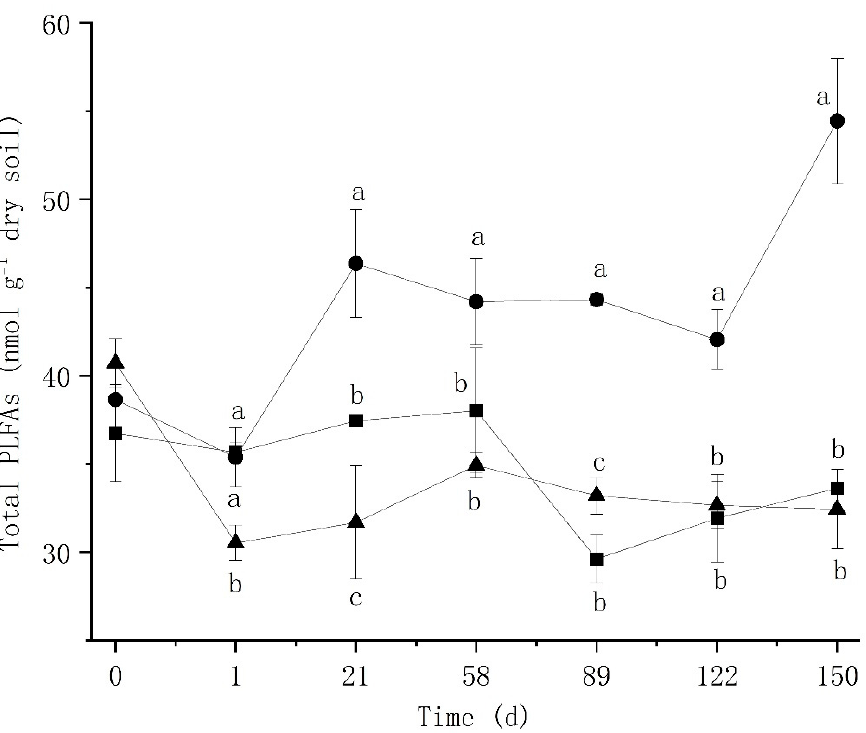
Figure 6. Soil PLFAs under different atrazine application treatments. Data represent the mean ± SD of each soil sample selected at each time-point. ( A ) Gram-positive bacterium (G+); ( B ) Gram-negative bacterium (G-); ( C ) bacterial; ( D ) fungal.